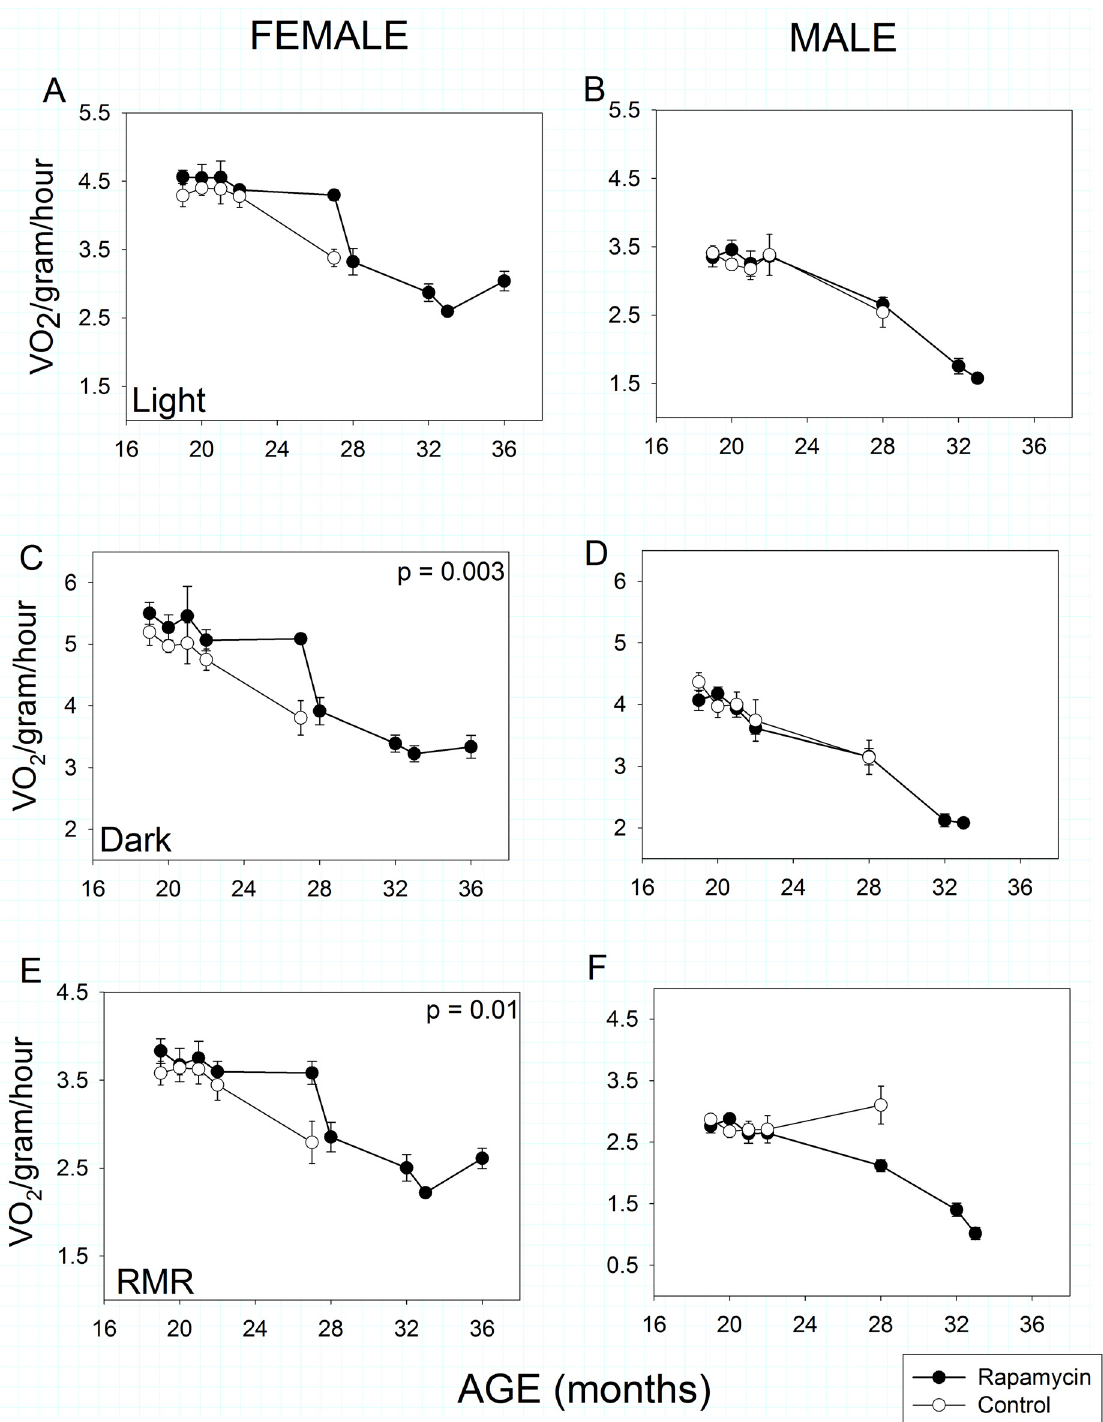
Fig 3. Metabolic activity in rapamycin-fed mice (filled circles) compared to controls (hollow circles). P-values shown on individual panels only if there is a significant treatment effect independent of age. Sample sizes varied, depending on age, control females, n = 8 – 4; rapamycin females, n = 11 – 3; control males, n = 9 – 5; rapamycin males, n = 16 – 2. A, B: Mass-specific metabolic rate during the light (= inactive) phase . Males and females showed no effects of rapamycin treatment on mass-specific metabolic rate during the inactive phase of their daily 24-hour cycle, although both sexes showed highly significant (p << 0.001) sex x age treatment effects. C, D: Mass-specific metabolic rate during the dark (= active) phase . Aging rapamycin-fed females, but not males, maintained significantly higher metabolic rates between measures taken at 24 and 28 months of age compared to controls during the dark (=